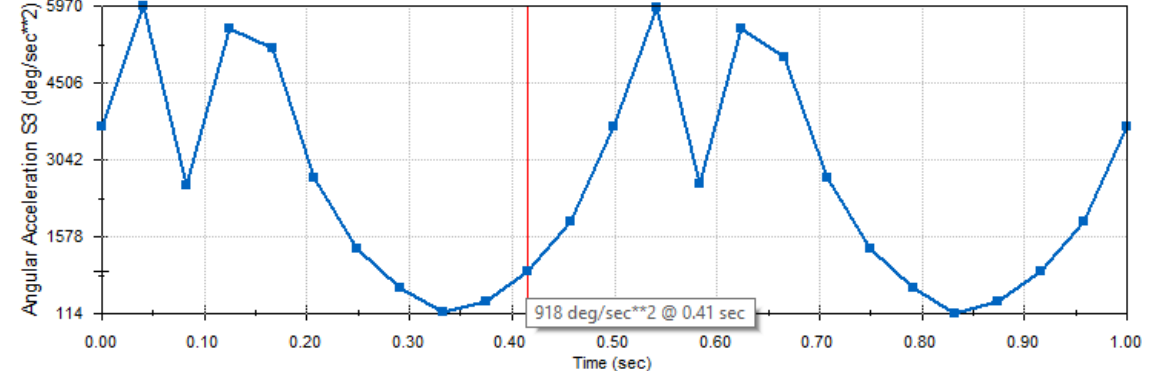
Figure 13. O B crank center of mass (S 2